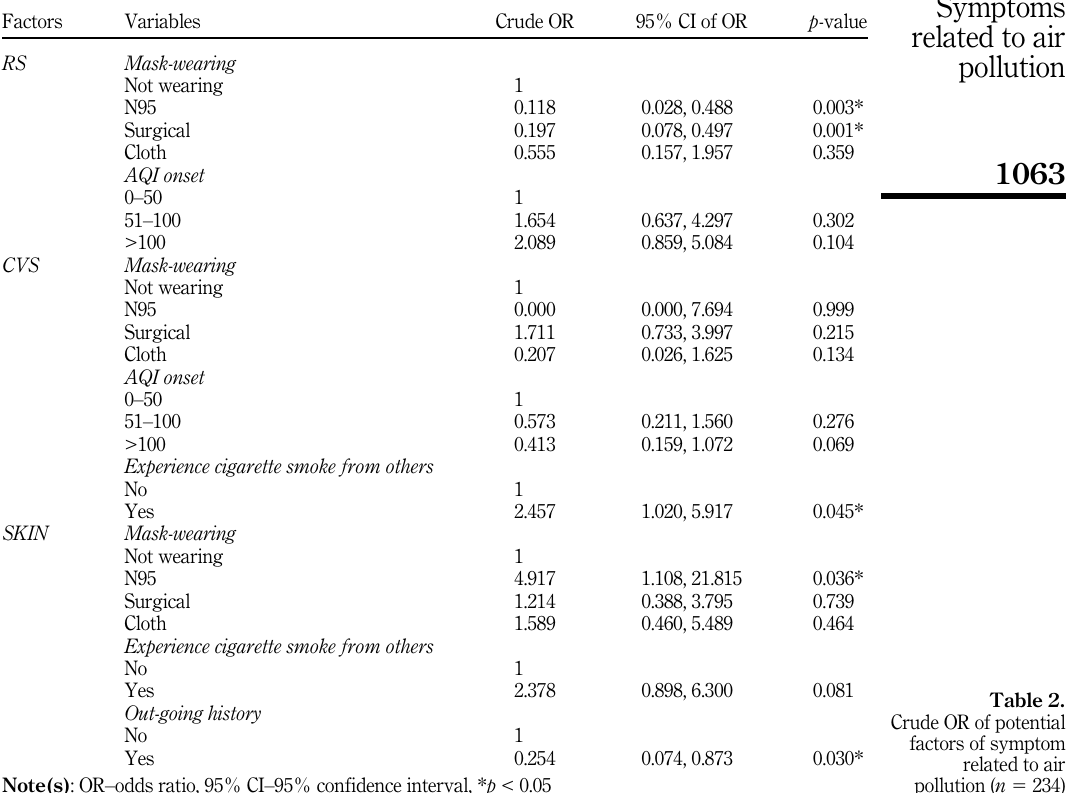
Table 2. Crude OR of